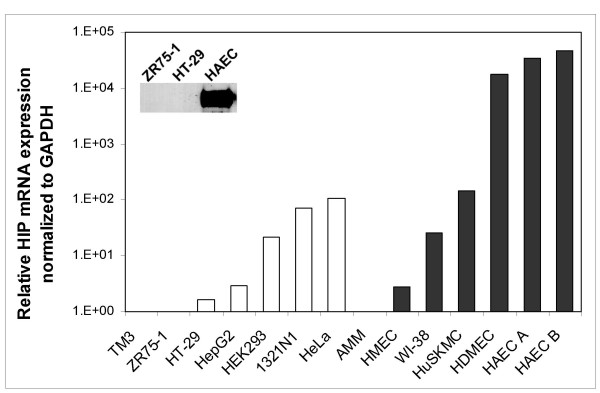
Comparison of HIP expression in different cell types. Total RNA from each cell type was assayed for HIP and GAPDH mRNA levels by Q-RT-PCR. Relative HIP mRNA expression was normalized to GAPDH and plotted on a log scale. Open bars, immortalized or cancer cell lines; filled bars, normal cells. TM3, mouse testicular epithelial cell line; ZR75-1, human breast cancer cell line; HT-29, human colon cancer cell line; HepG2, human liver cancer cell line; HEK293, human kidney cancer cell line; 1321N1, human brain cancer cell line; HeLa, human cervical cancer cell line; AMM, activated mouse macrophage; HMEC, normal human mammary epithelial cells; WI-38, normal human lung fibroblasts; HuSKMC, normal human embryonic skeletal muscle cells; HDMEC, normal human dermal microvascular endothelial cells; HAEC A and HAEC B, normal human aortic endothelial cells from two different donors (obtained from Cascade Biologics and Clonetics, respectively).